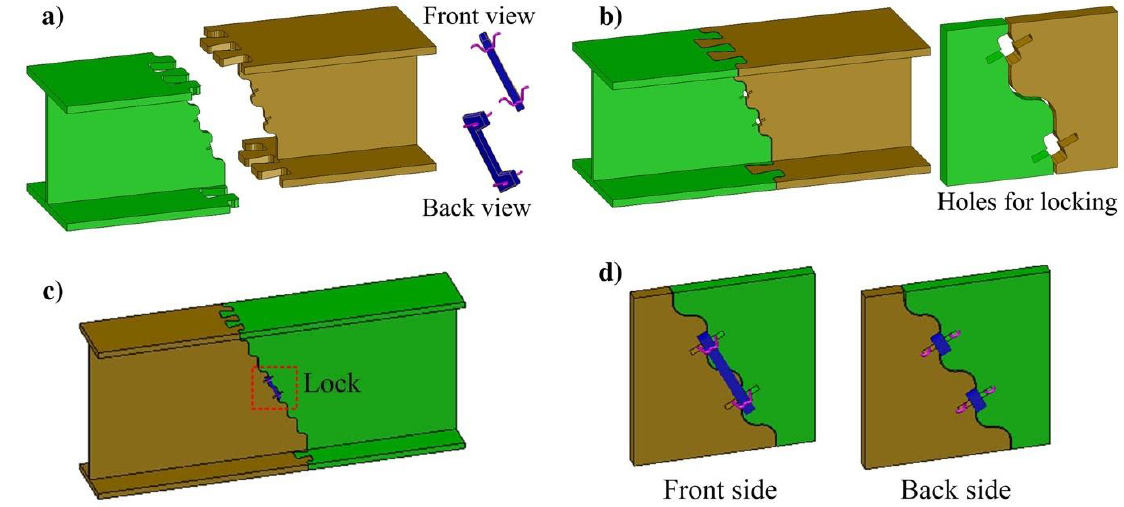
Figure 3. Front ISC: ( a ) front ISC components with lock; ( b ) assembled front ISC; ( c ) assembled and locked front ISC; ( d ) close-up of lock.